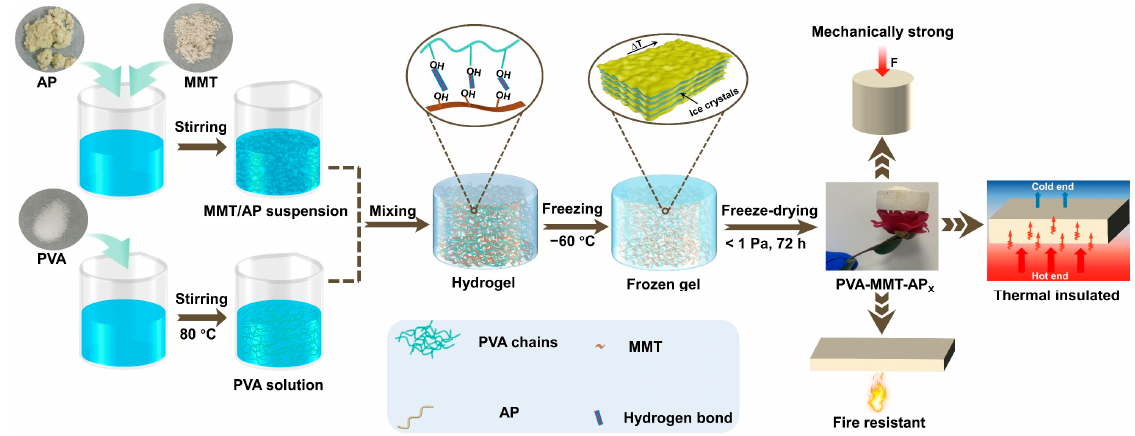
Figure 9. Schematic illustration for the preparation of PVA-MMT-APx aerogels